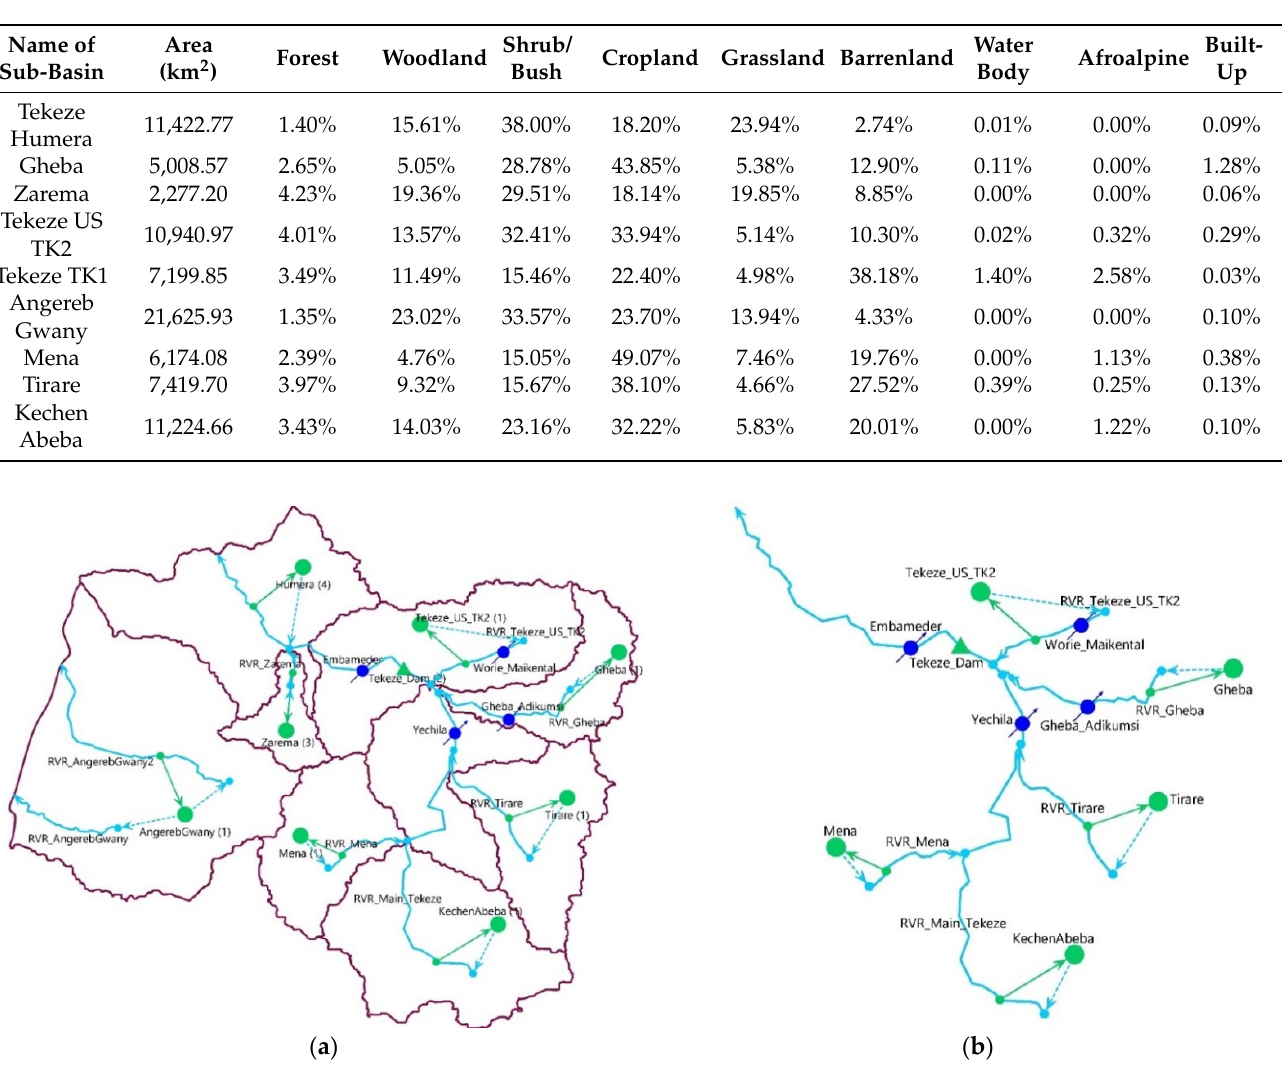
Figure 2. WEAP schematics showing objects used to simulate the basin hydrologic process for the Tekeze River Basin. ( a ) shows the overall model boundary is hown where green circles represent the sub-basins; rivers that receive catchment runoff (represented by blue broken arrows) are connected by transmission lines (green arrows) to represent water diversion back to the catchment for irrigation. ( b ) shows the main Tekeze River and tributaries with gauging stations (deep blue circles) are used for flow calibration. Green Triangle shows the Tekeze Hydropower Dam.